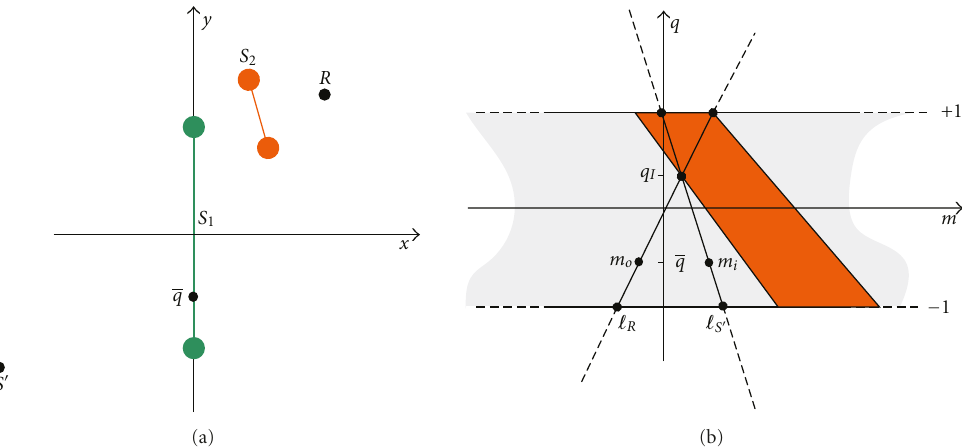
Figure 10: Normalized geometric domain (a) and corresponding dual space (b). The lines (cid:2) R and (cid:2) S (cid:6) are the dual of the points S (cid:6) and R .